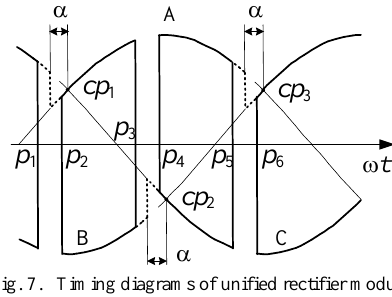
Fig. 7. Timing diagrams of unified rectifier module.